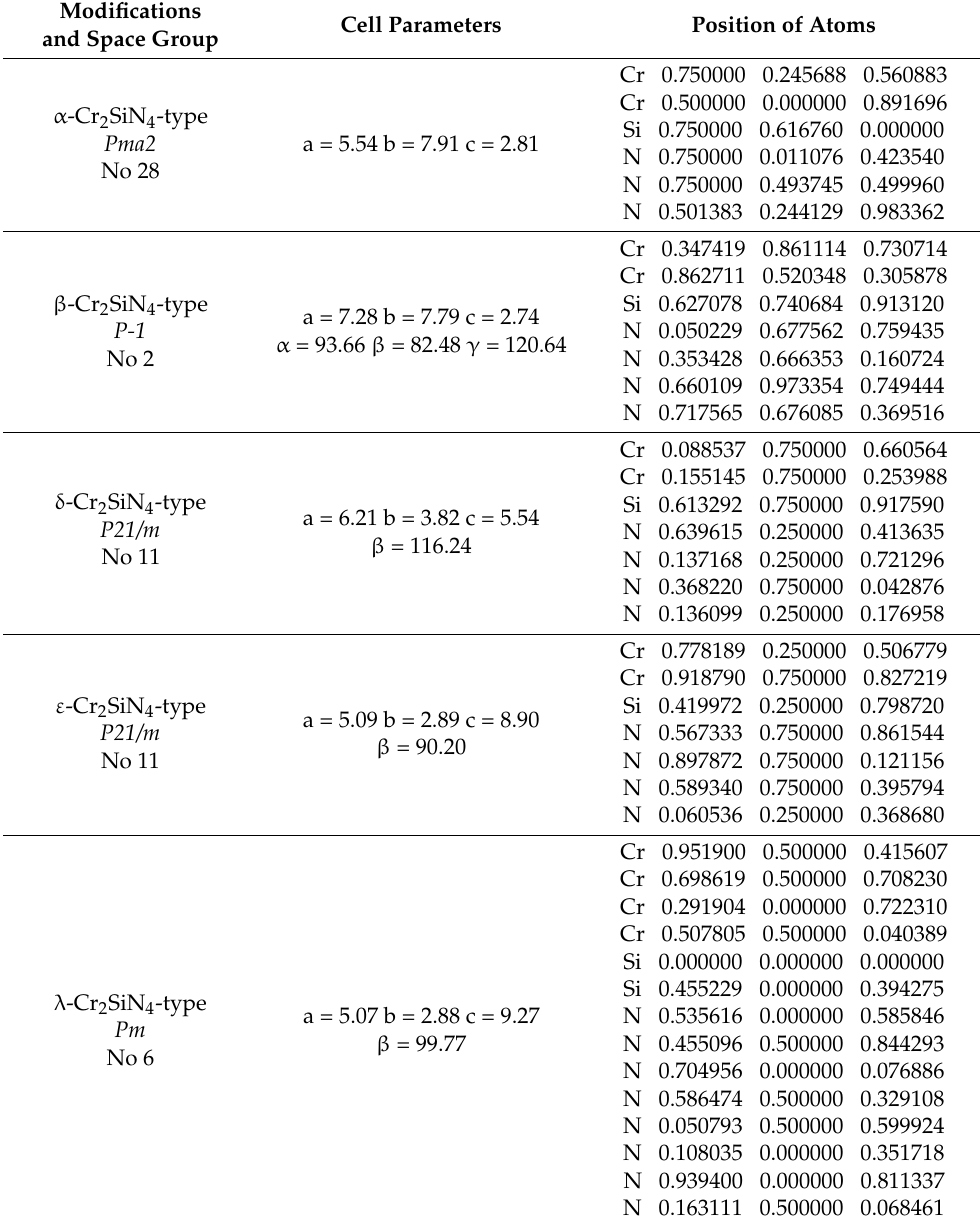
Table 2. The modifications, space groups, unit cell parameters, and atomic positions for favorable Cr 2 SiN 4 modifications found after global optimization and later locally optimized on the ab initio level using the GGA-PBE